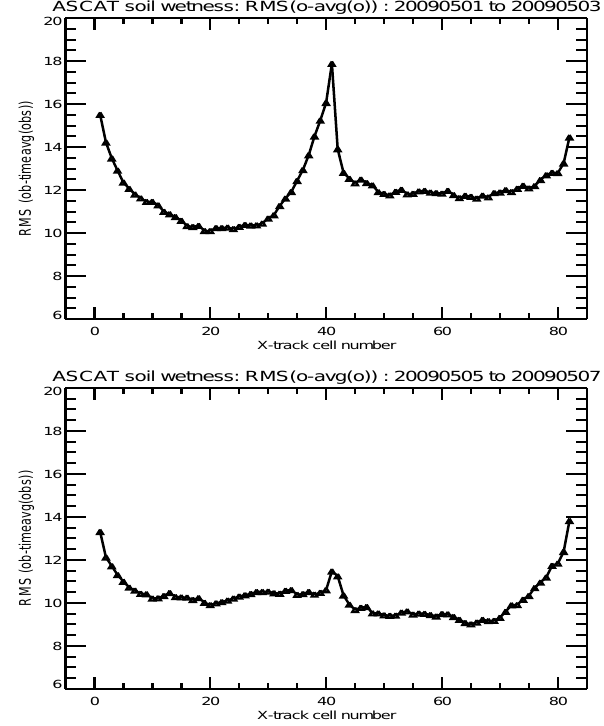
Fig. 4. Error in ASCAT surface soil wetness measurements as a function of cross track cell number. The upper panel shows errors for the 3day period; 1 May 2009 to 3 May 2009. On 4 May 2009, EUMETSAT implemented an operational improvement to the ASCAT backscatter bias correction. The lower panel shows errors for the 3day period; 5 May 2009 to 7 May 2009. The benefit of the improved bias correction by EUMETSAT is clearly visible in the lower panel, showing significantly smaller errors.